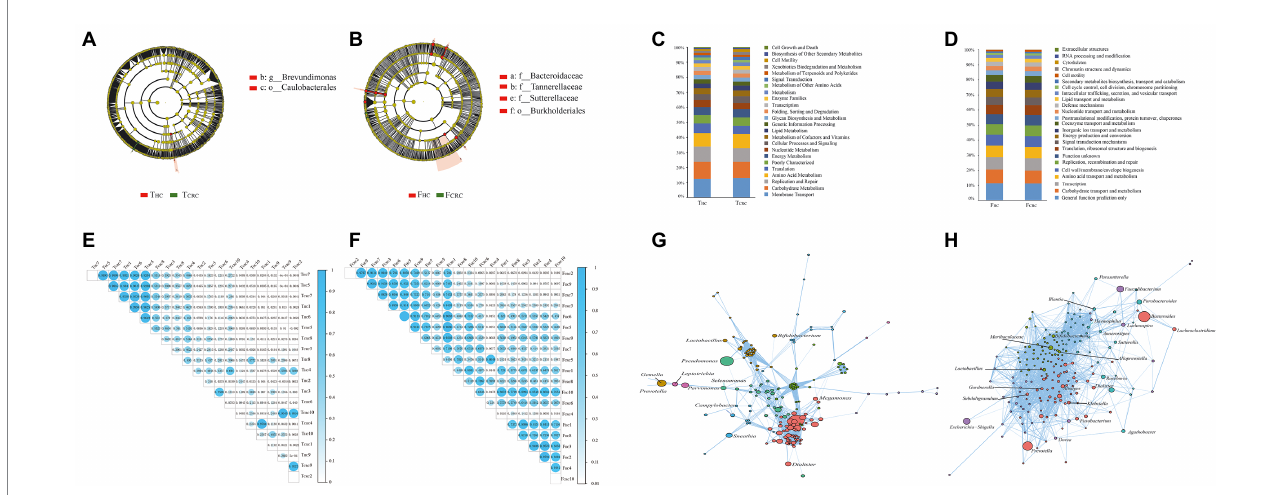
FIGURE 2 Most differentially abundant taxa between the T HC and T CRC (A) , and between the F CRC and F HC groups (B) based on LEfSe analyses, respectively. Functional predictions between the T HC and T CRC (C) , and between the F CRC and F HC groups (D) based on PICRUSt analyses, respectively. Correlation analysis in all samples of T HC and T CRC (E) , and the F HC and F CRC (F) , and the network analysis in T HC and T CRC (G) , and the F HC and F CRC (H)